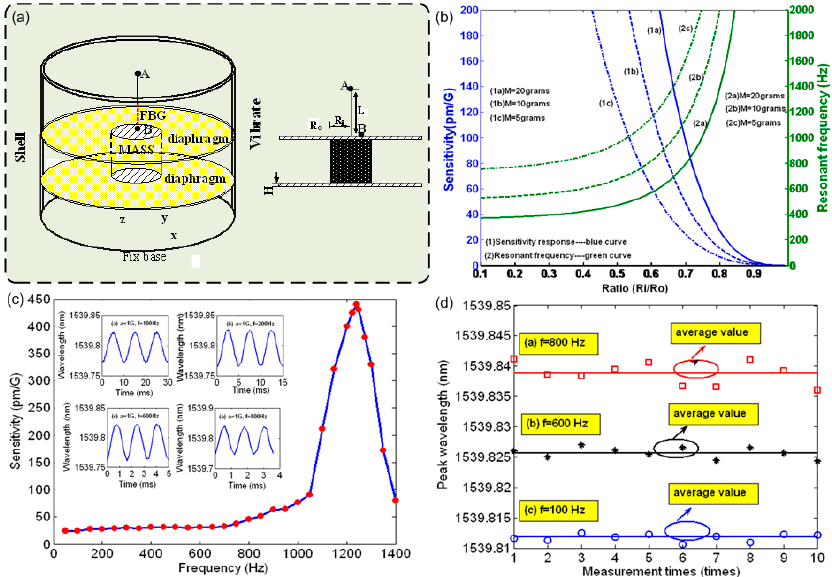
Figure 4. ( a ) Schematic diagram of FBG accelerometer based on double diaphragms; ( b ) Simulated sensitivity and resonant frequency as a function of mass diameter; ( c ) Frequency response of accelerometer (insets show the time-domain variation of resonant wavelength for vibration frequencies 100, 200, 600 and 800 Hz); ( d ) Stabilities of the accelerometer under the vibrations with the different frequencies.